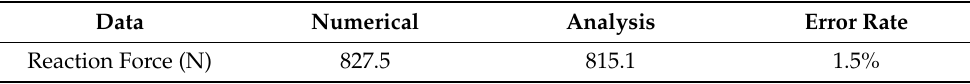
Table 5. Comparison of reaction force data of water tank according to pump operation.